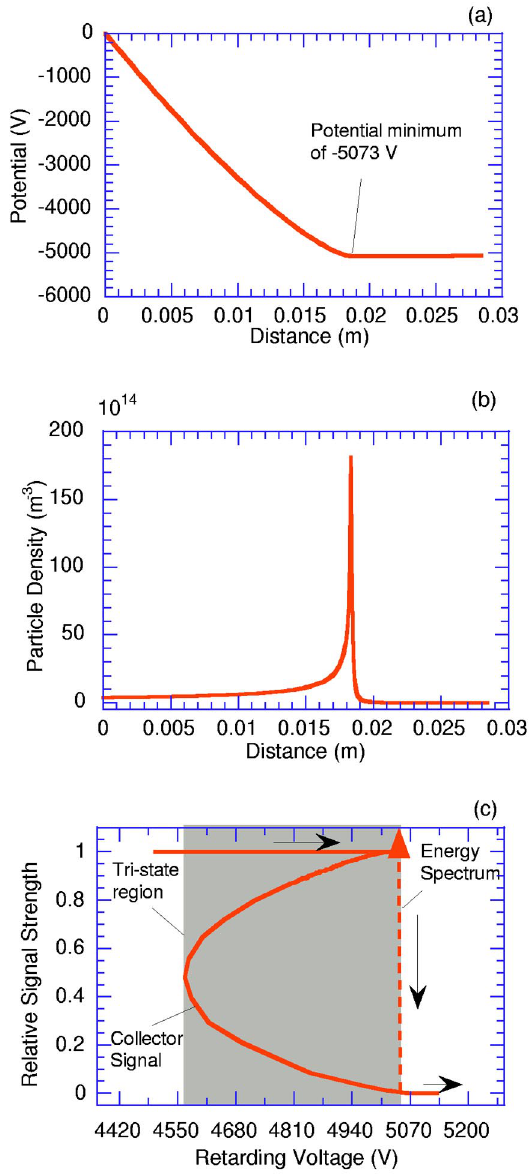
FIG. 10. (Color) Simulation of the energy analyzer perform- ance for (cid:19) (cid:3) 1 : 2 . (a) Potential distribution with retarding voltage at (cid:7) 5067 V . The potential minimum is (cid:7) 5073 V . (b) Particle density distribution with retarding voltage at (cid:7) 5067 eV . (c) Energy analyzer collector signal and energy spectrum. Because of the state jump, the energy spectrum is close to a delta